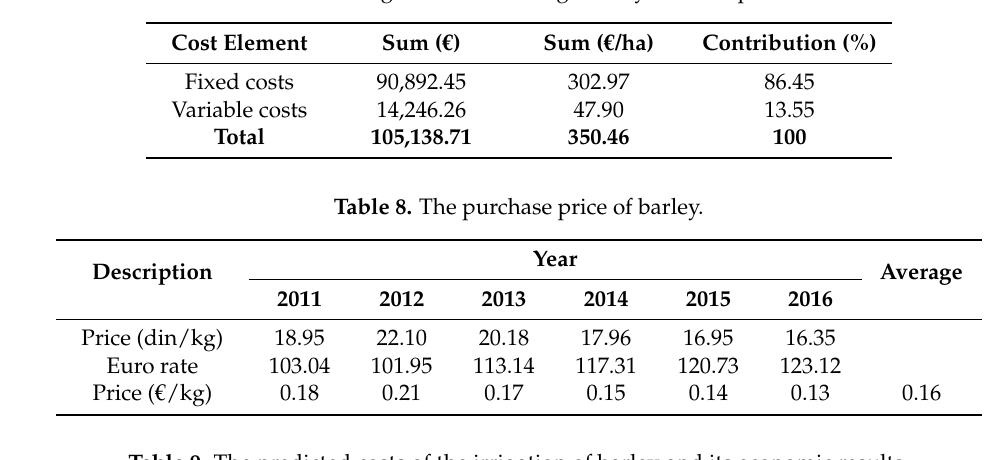
Table 7. The average costs of the irrigation system’s exploitation.